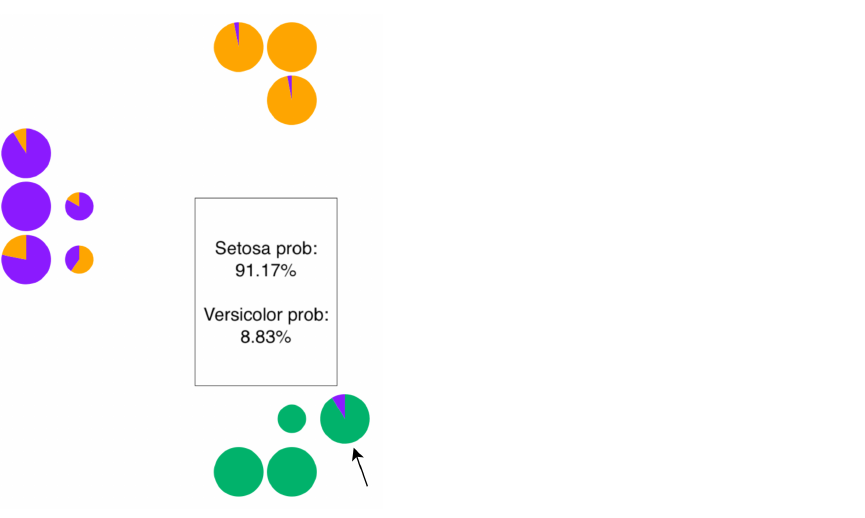
Figure 3. Forest View: visualizing the forest of logic rules (decision paths) in the Random Forest model. Shows high (big circles) and low (small circles) coverage paths. Strong knowledge clusters are seen to be formed inside the model. Individual class probabilities can be seen when hovered over a rule, as shown by the